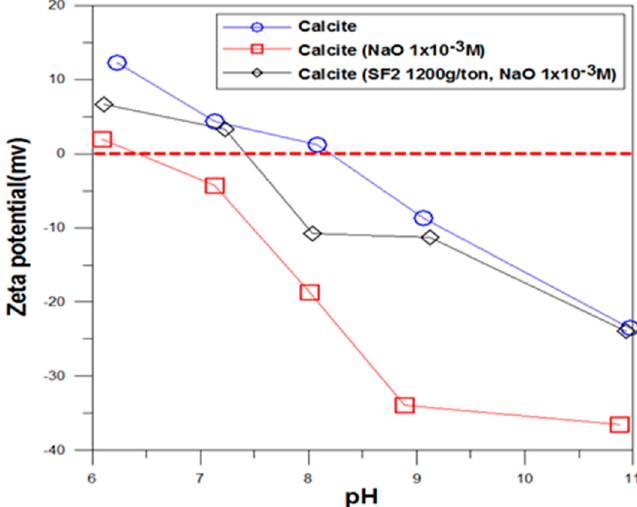
Figure 7. Zeta potentials of calcite with and without the collector and depressant.